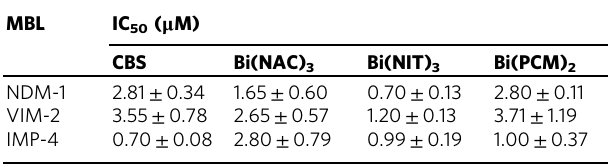
Table 2 IC 50 values of Bi(III) compounds against